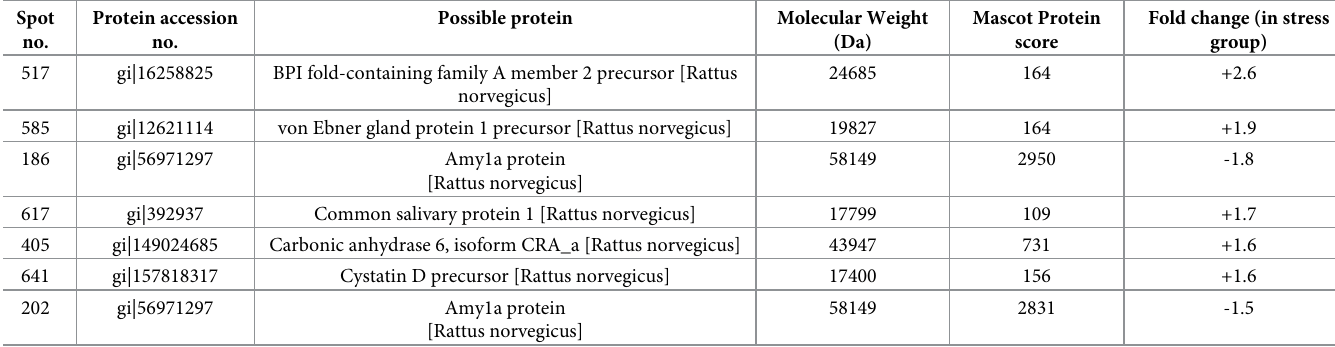
Table 2. Identification of the protein spots by mass spectrometry. Spot